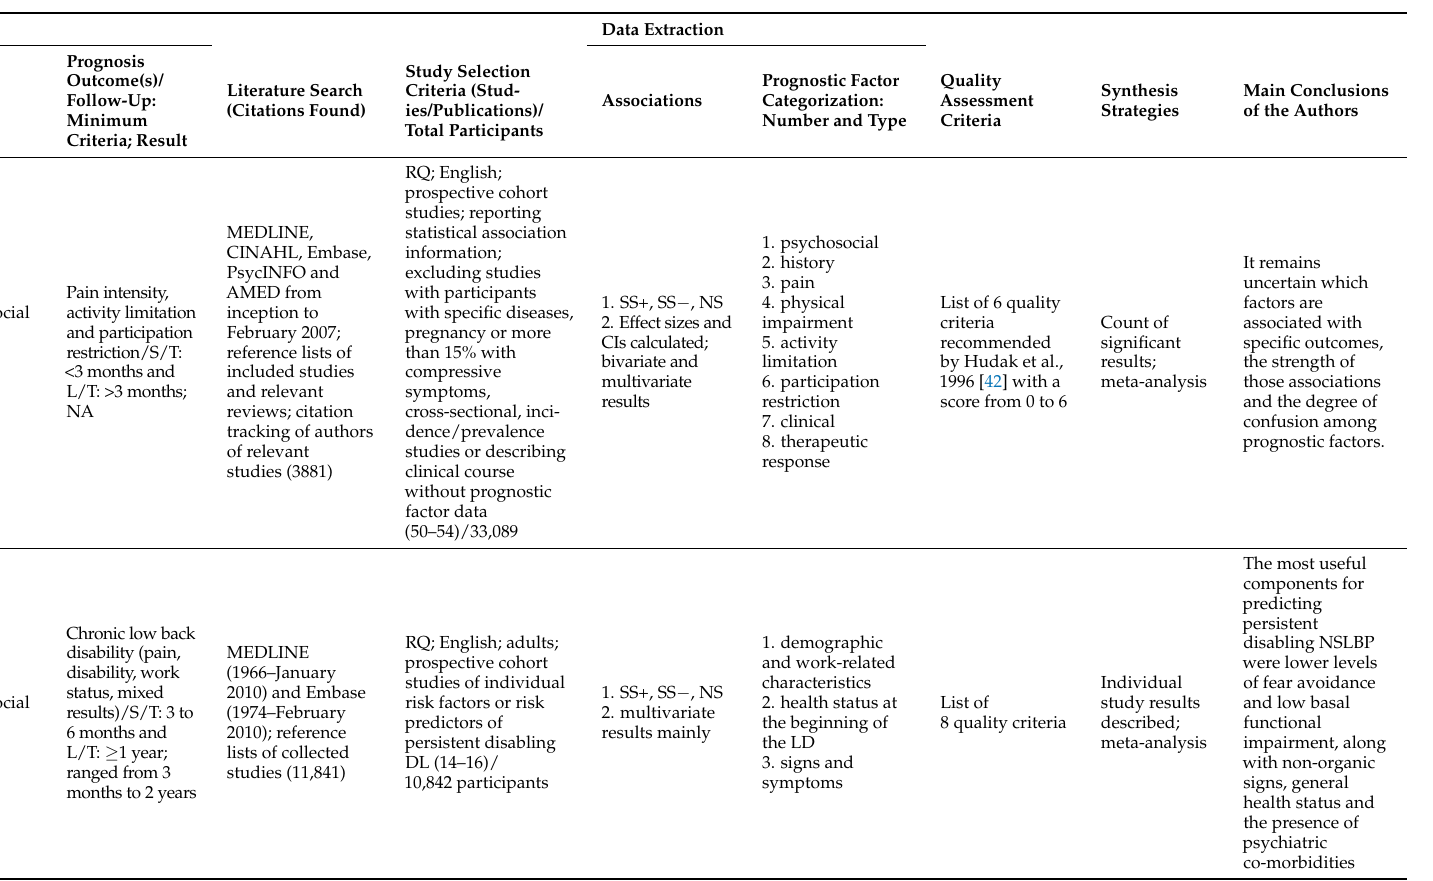
Table 1. Characteristics of the included low back pain prognosis systematic